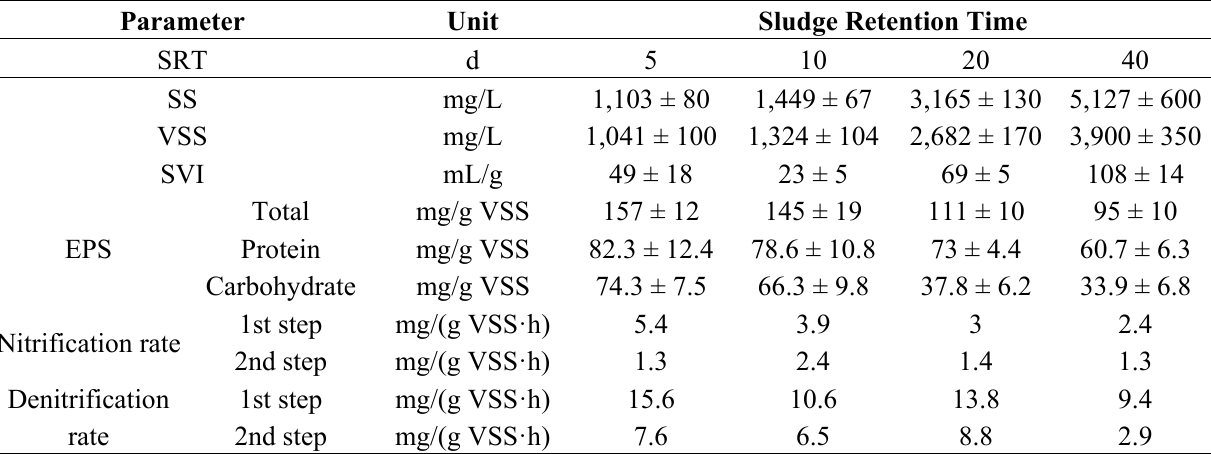
Table 2. Sludge characteristics under different